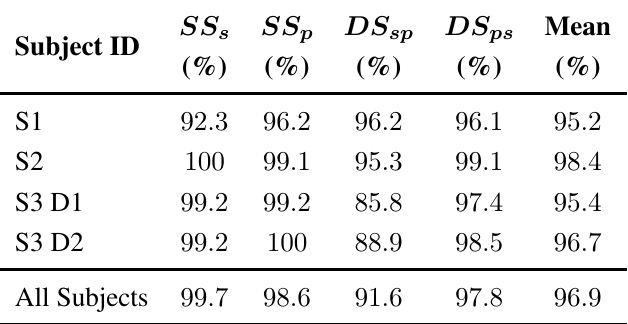
Table 6. Success rates for the online detection of gait phases using the rule-based